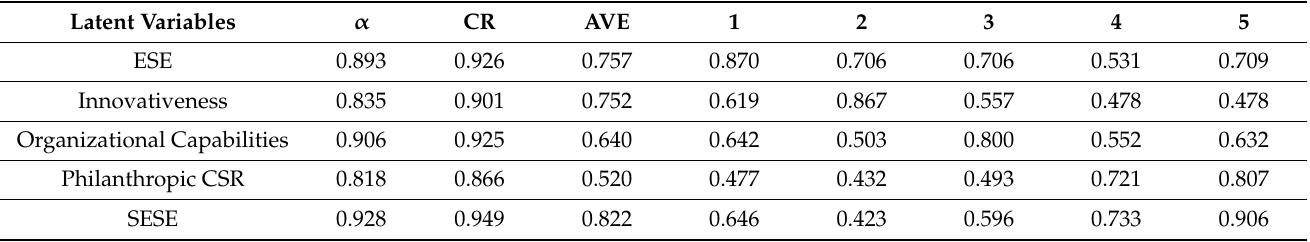
Table 1. Composite reliability, average variance extracted, correlations, and discriminant validity